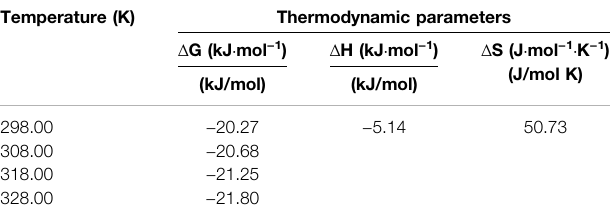
TABLE 4 | Thermodynamics parameters of Sr(II) adsorption on PMBN3.